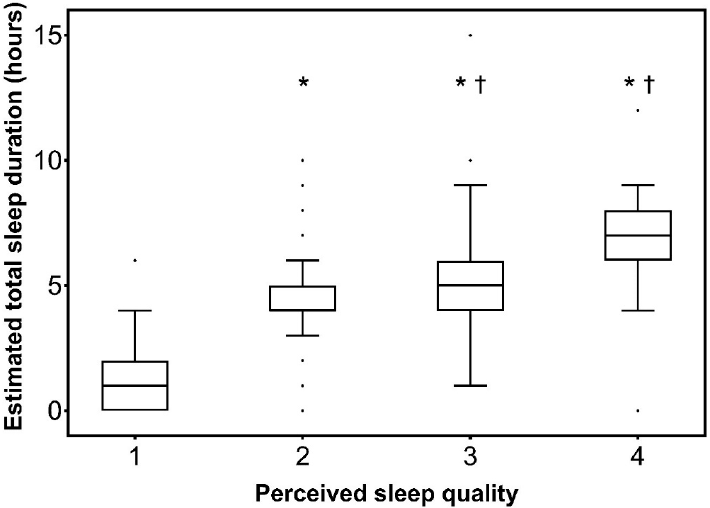
Table 1. Univariate and multivariate analysis: factors associated with poor perceived sleep qual ‐ ity.